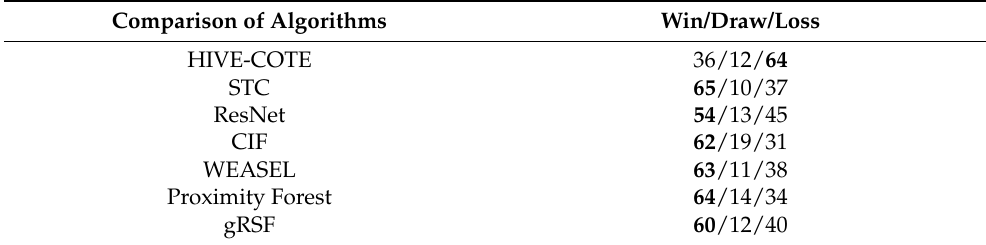
Table 4. Pairwise comparison of RSFCF and 6 comparison algorithms in terms of accuracy over 112 UCR datasets. Comparison of Algorithms Win/Draw/Loss